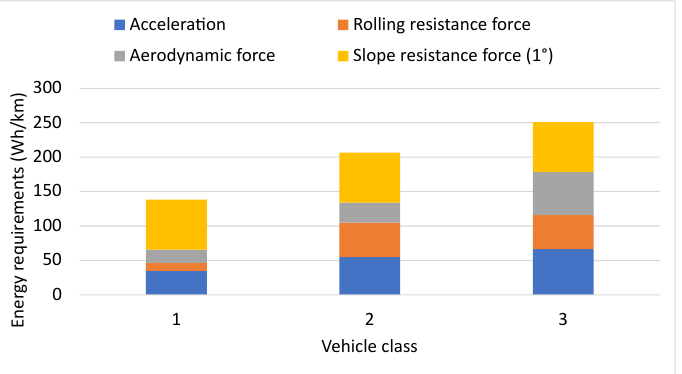
Figure 4. Energy requirements for standard vehicle (Table 1) using WLTP driving